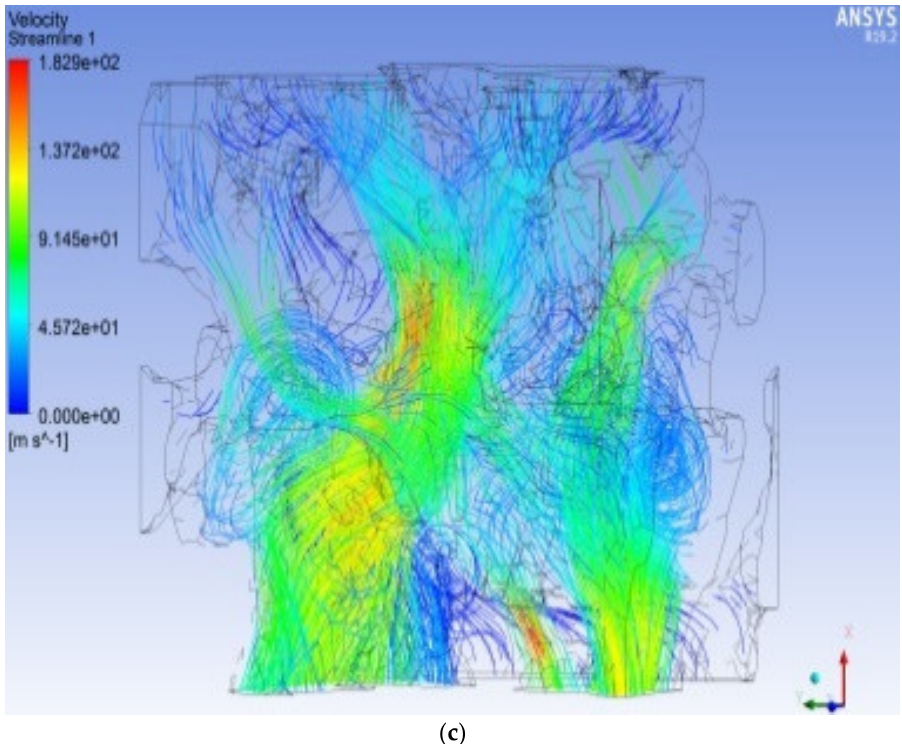
Figure 8. Streamline diagram of seepage velocity distribution at the X direction entrance under different pressures.